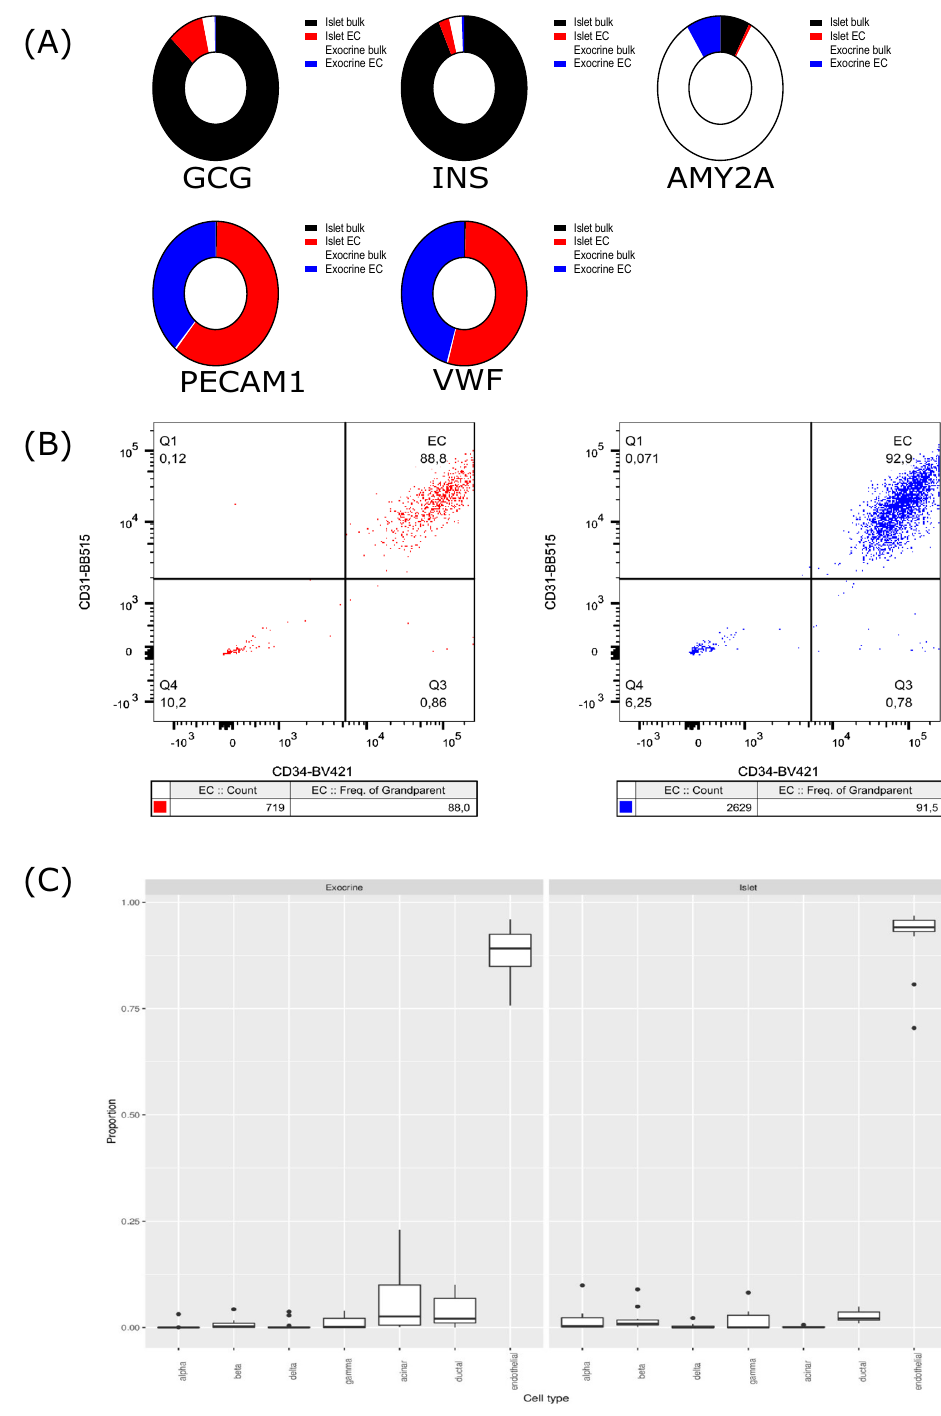
Figure 1. ( A ) Summarized RT-qPCR data for all included sorted samples and associated bulk samples. The sums of the 2^dCT values are used to plot the contribution of each sample type to the total expression of the target genes. Red—islet endothelial cell sample signal, blue—exocrine endothelial cell sample signal, black— bulk (non-sorted) islet tissue signal, white—bulk (non-sorted) exocrine tissue signal. n = 12 (islet bulk), 12 (islet EC), 13 (exocrine bulk) and 13 (exocrine EC). ( B ) Flow cytometric analysis of sorted cells. Dot plots are presented from one representative sorted islet sample (left—from normo2) and one representative sorted exocrine sample (right—from normo5), indicating that endothelial cells constitute 88% and 91.5% of all cells in these samples. All sorted samples were analyzed and samples closest to the median values were designated representative samples. ( C ) Deconvolution of RNA-Seq data into estimated proportions of alpha, β, delta, gamma, acinar, ductal, and endothelial cells in exocrine (left) and islet (right) tissue. The proportions were estimated from the raw counts using Multi-subject Single Cell Deconvolution (MuSic). All proportions sum to one. n = 13 (exocrine) and n = 12